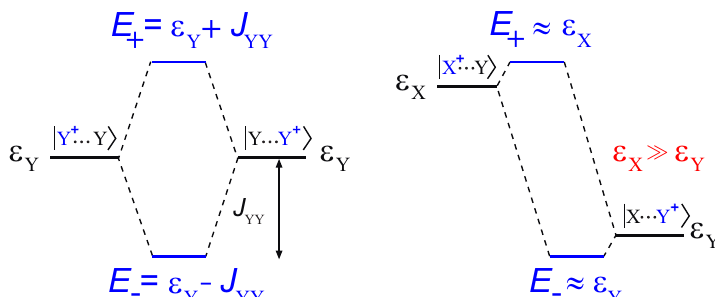
Figure 5. The two limiting cases predicted by the two state model for the ionization energy of two stacked nucleobases. ( Left ) The remotion of an electron from two identical unstacked Y nucleobases (cid:12) (cid:12) (cid:11) (cid:11) pair gives rise to two diabatic states, and with hole energy ε Y ; upon formation of (cid:12) Y + · · · Y (cid:12) Y · · · Y + a π stacking interaction, the two states are coupled each other, and the energy levels of the electron hole ( E + , E − ) are shifted up and down with respect to those of unstacked pair by the quantity J YY , representing the strength of the π stacking interaction. ( Right ) If the hole energy of X is far larger than that of Y, then the J XY coupling term is not effective in lowering the ionization energy of the stack, so that the lowest eigenvalue of H , E − , is nearly coincident with ε Y , and the highest eigenvalue of H , E + , is nearly coincident with ε X